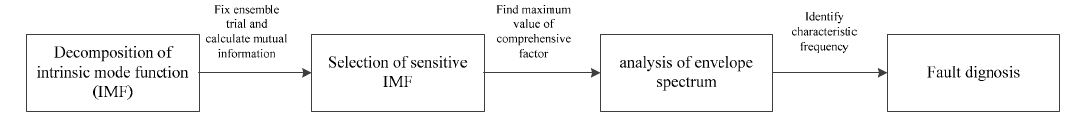
Figure 20. Experimental data of inner and outer raceway fault. 4.4.1. Case 1 Bearing with an Inner Raceway Fault The following expression is the theoretical characteristic frequency of the inner raceway fault ( in f ):